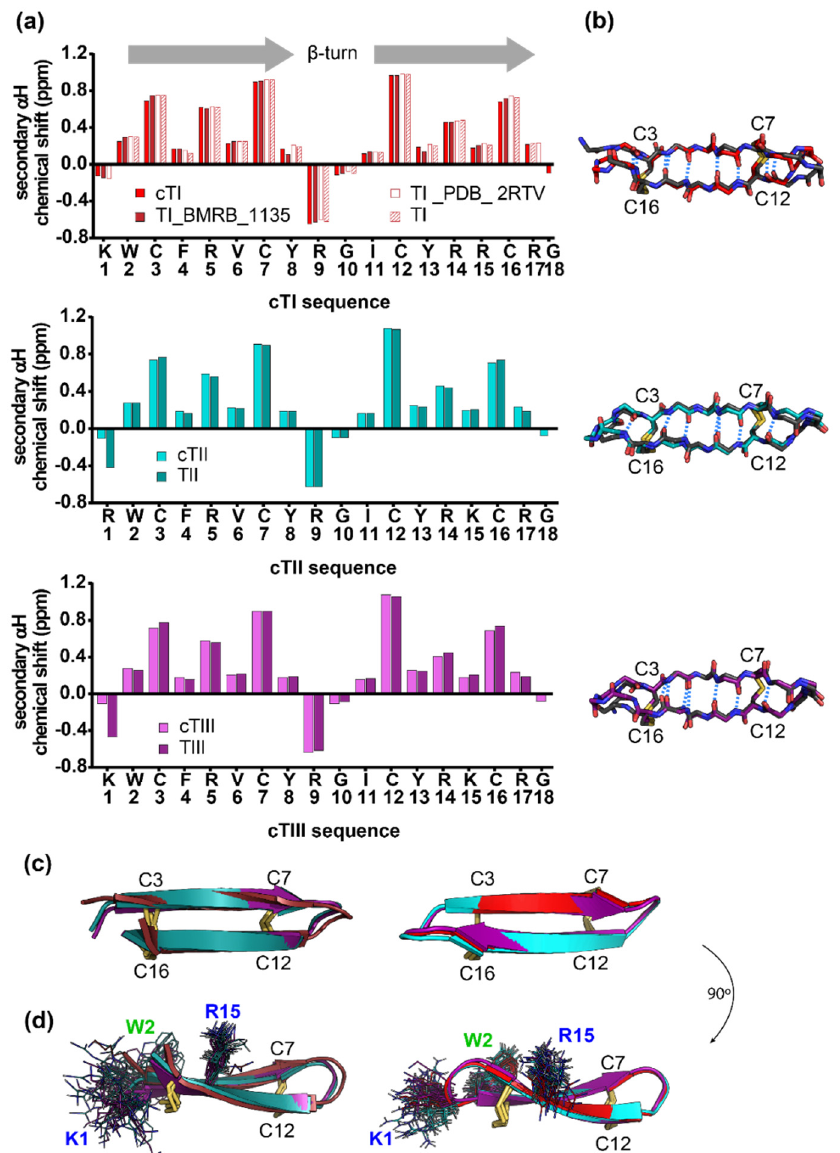
Figure 1. The NMR structures of TI and cTI (red), TII and cTII (cyan), TIII and cTIII (magenta). ( a ) Secondary α H chemical shift at 298 K determined from 1 H NMR spectra. Shifts were calculated by subtraction of random coil 1 H NMR shifts [41] from the experimental values. For tachyplesin I (TI), the shifts of the peptide synthesized in our lab were compared to shifts obtained from data banks: TI—PDB ID 2RTV [37], and TI—BMRB ID 1135 [38]. Positive shifts greater than 0.1 ppm suggest β -strands, indicated by grey arrows. ( b ) Overlay of the cyclic analogues (colored backbone) with their respective parent peptide (grey backbone). Hydrogen bonds between β -strands are indicated in blue. The structure of TI was obtained from the PDB (ID 1WO0). ( c ) Overlay of TI–TIII and cTI–cTIII. ( d ) Mobility of the residues (K or R) at position 1 and 15, which differ between the peptides, and of W2 of the native sequences and cyclic analogues, respectively.